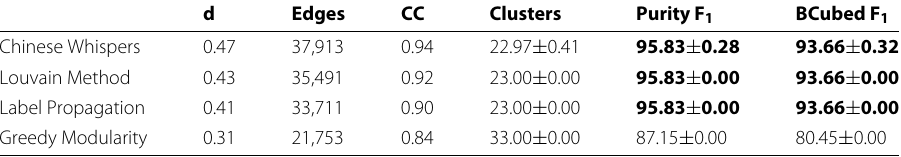
Table 3 Semantic frame induction results achieved using different community detection algorithms d Edges CC Clusters